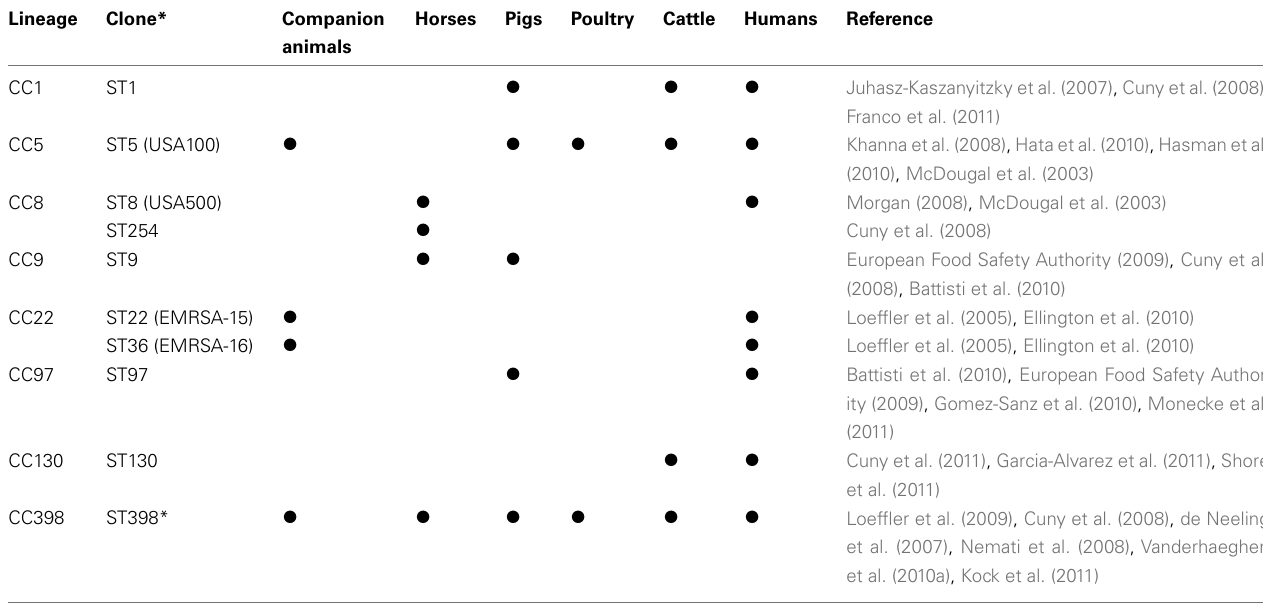
Table 2 | Principal MRSA clones shared between animals and humans.